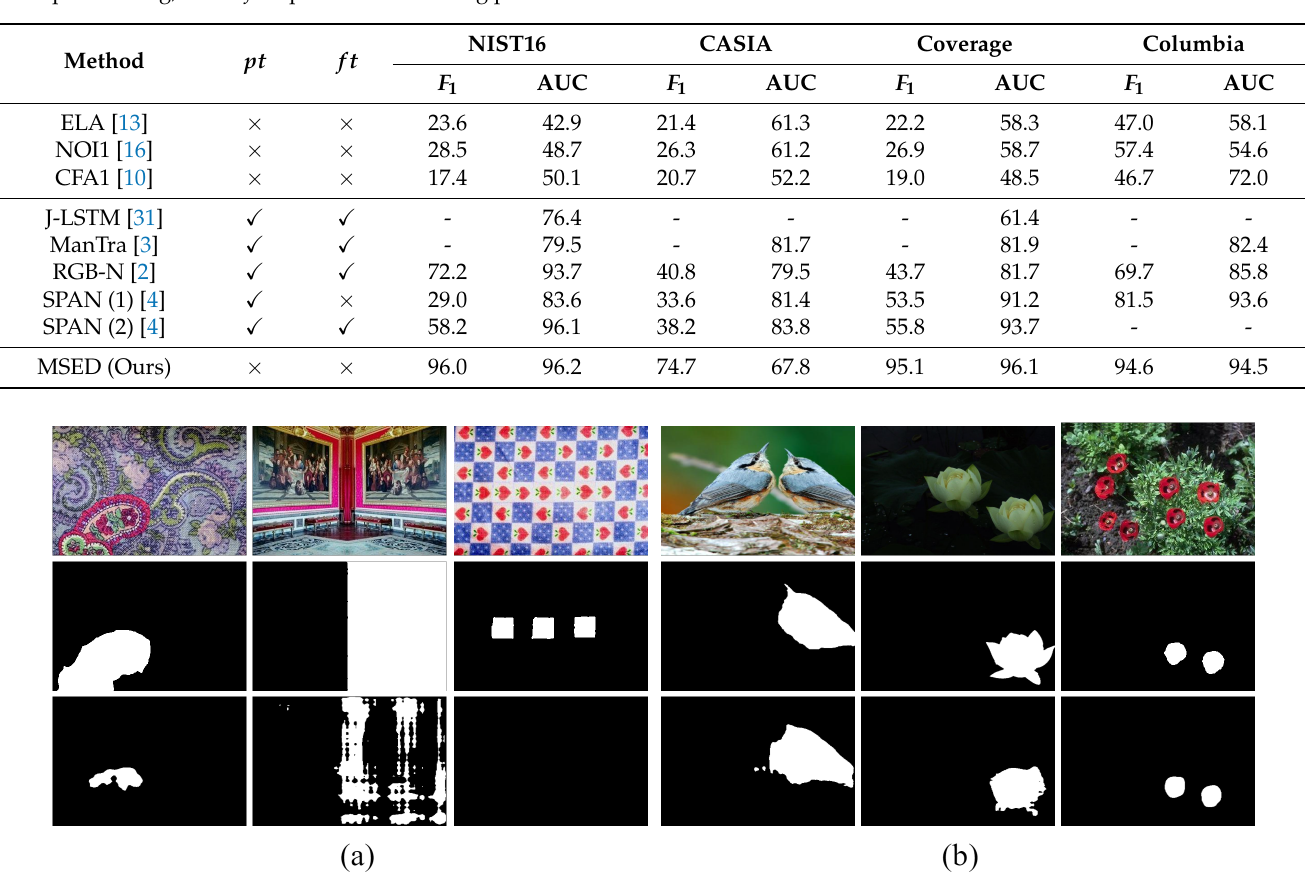
Figure 5. MSED detection results on copy-moved images on CASIA. ( a ) represents manipulated images with flipping manipulation and similar patterns within an image which are difficult to localize. ( b ) denotes the other types of copy- moved